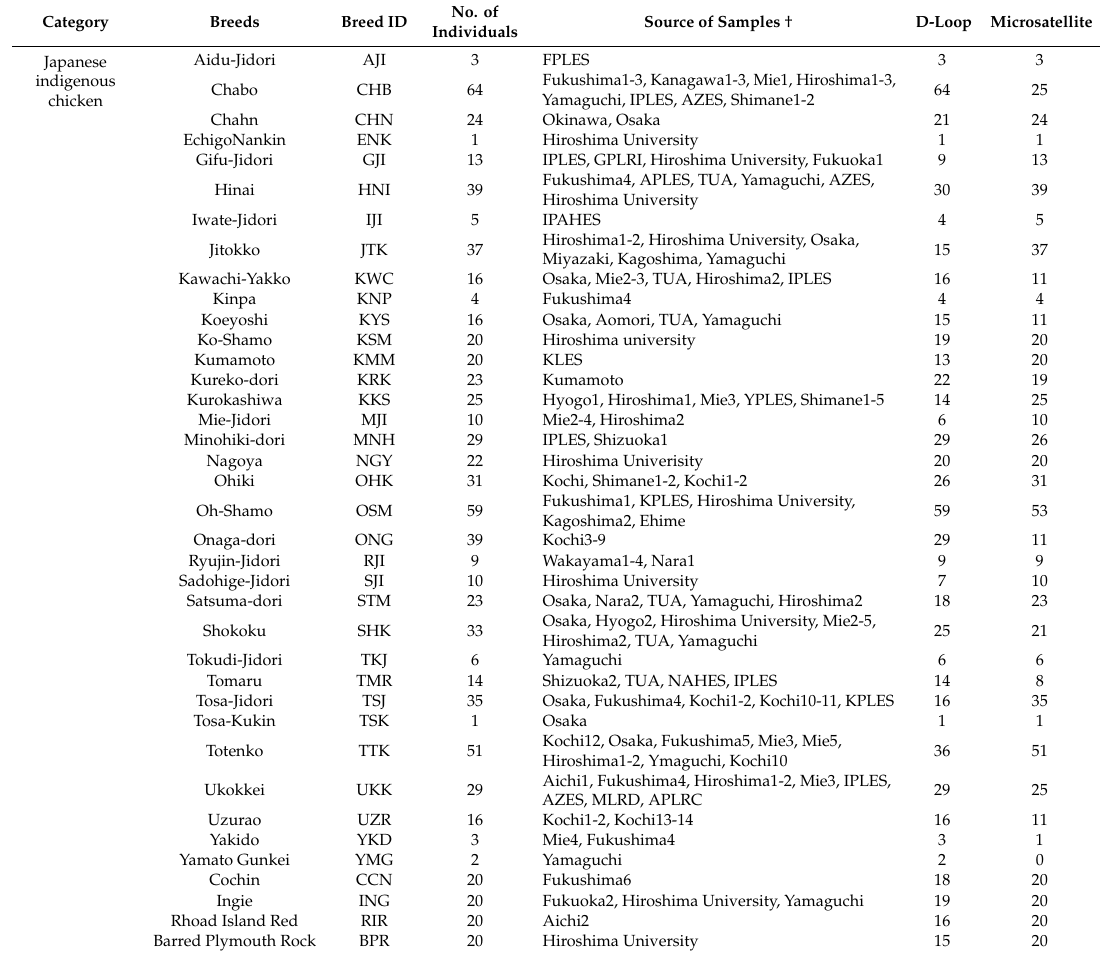
Table 1. List of breeds of Japanese indigenous chickens and indigenous chickens overseas examined in this study. Category Breeds BreedID No. of Individuals Source of Samples † Japanese indigenous chicken